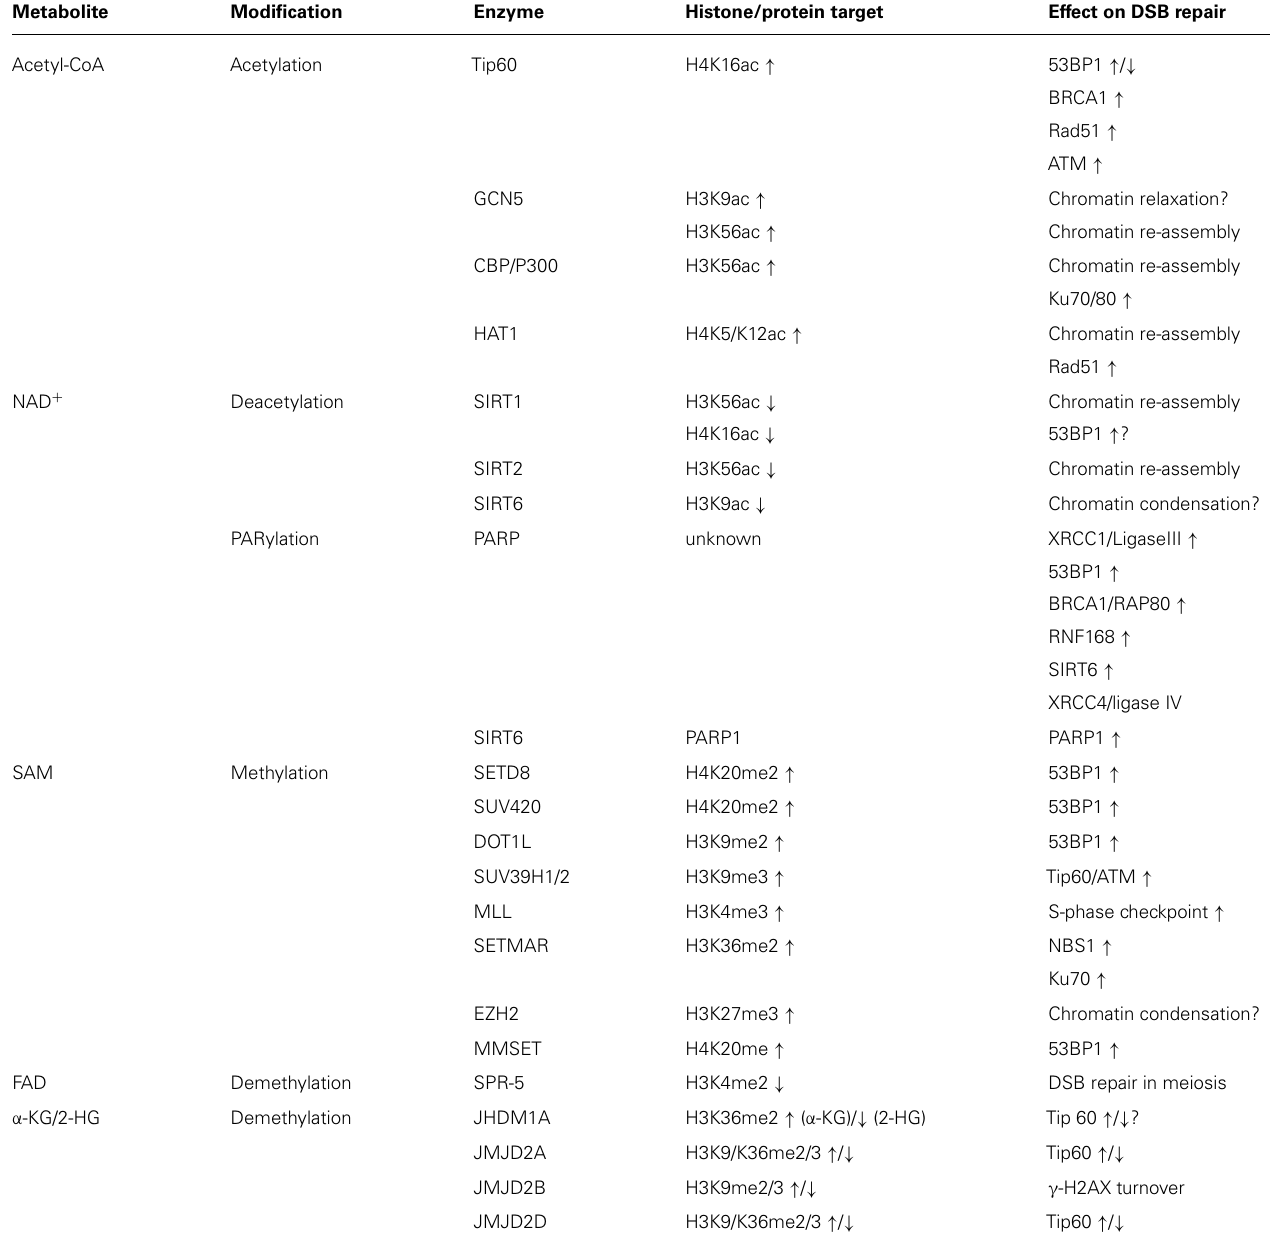
Table 1 | Metabolite-sensitive chromatin modifiers involved in DSB